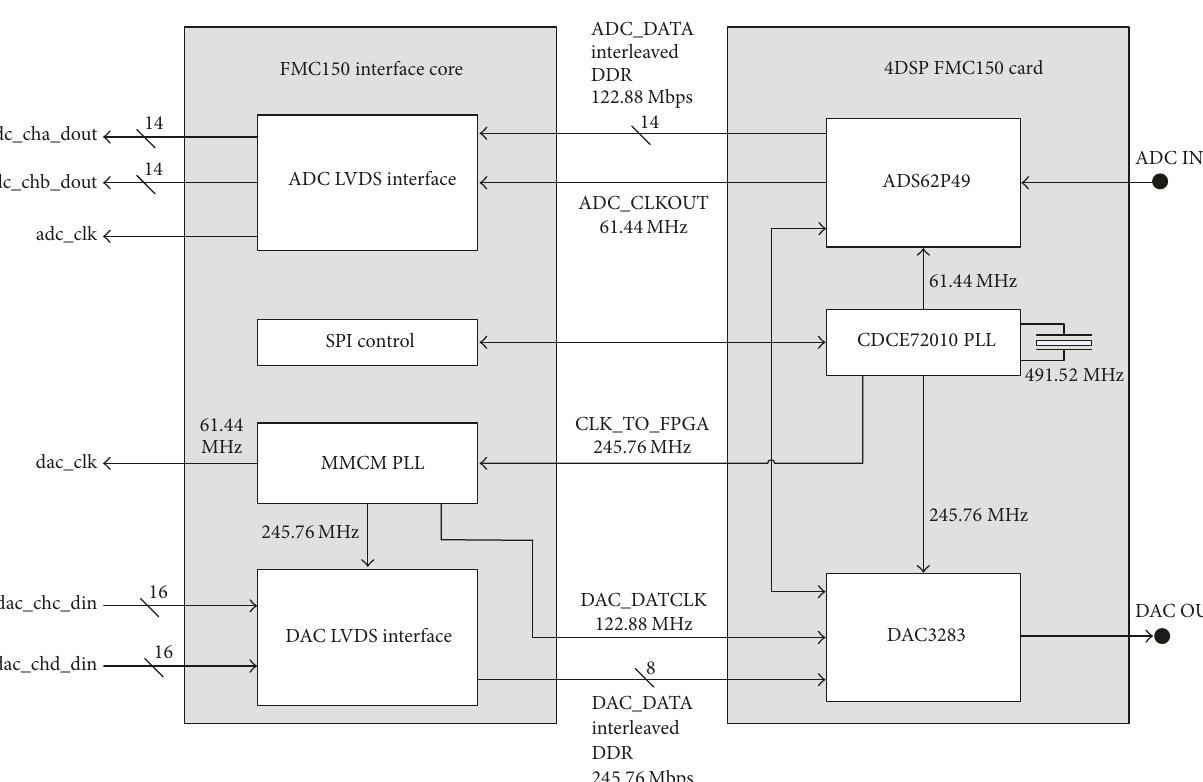
Figure 10: Structure of FMC150 core interfacing with the 4DSP FMC150